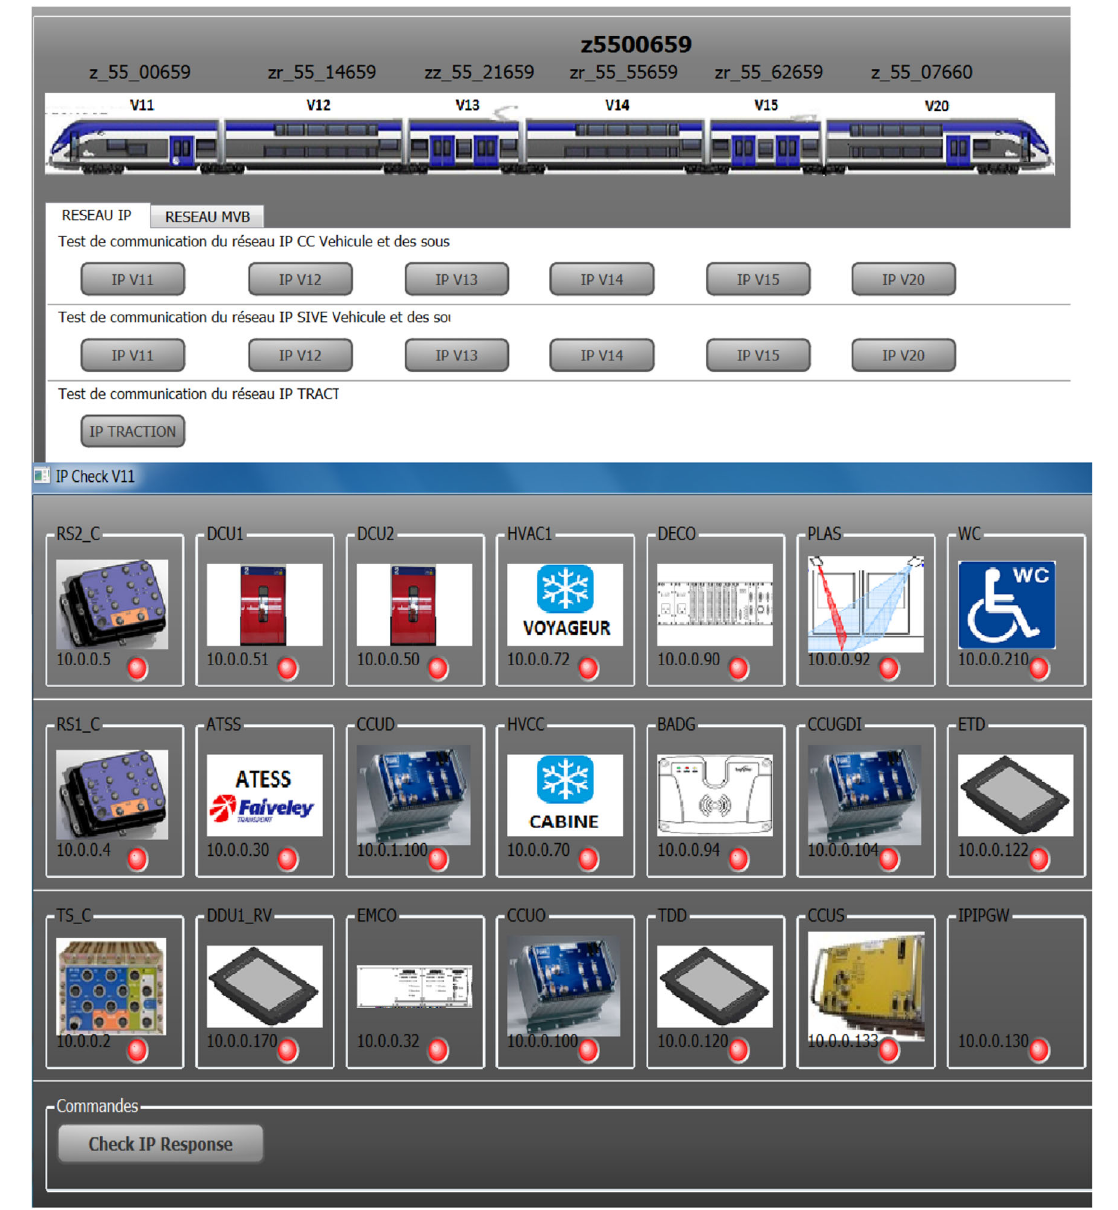
Fig. 15 Troubleshooting help tool: user interface Table 3 Results achieved